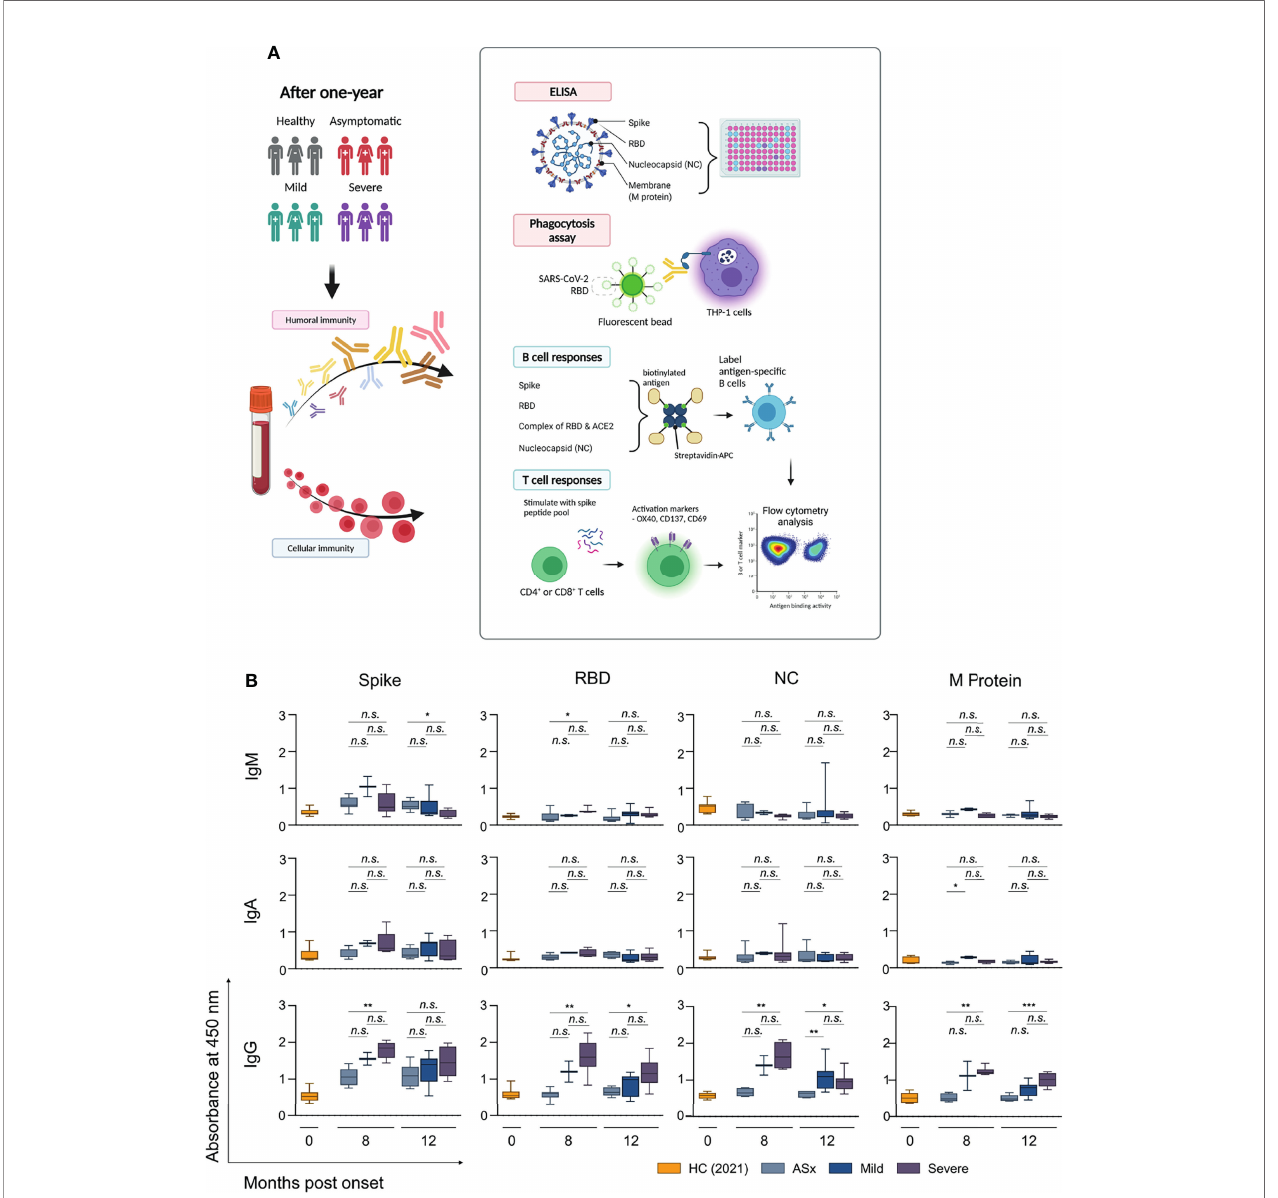
FIGURE 1 | Longitudinal analysis of anti-SARS-CoV-2 antibody in COVID-19 patients over time according to the severity of illness. (A) Schematic illustration (created with BioRender.com) of experimental design for analyzing humoral and cellular immune response to SARS-CoV-2 according to the disease severity, including Figures 1 – 4 . (B) Binding activities of each Ig isotype to SARS-CoV-2 proteins. Diluted plasma samples (1:100) in PBS were incubated with SARS-CoV-2 spike protein, receptor- binding domain (RBD), nucleocapsid (NC), and M protein. Corresponding isotyping Abs determined binding activities of IgM, IgA, and IgG to SARS-CoV-2 antigens. ASx, asymptomatic (8-month: n = 7, 12-month: n = 6), Mild (8-month: n = 2, 12-month: n = 9), Severe (8-month: n = 7, 12-month: n = 8). Statistical analyses were performed using the Kruskal – Wallis rank-sum test with Dunn ’ s post hoc test in GraphPad Prism ( n.s .: P > 0.05, * P < 0.05, ** P < 0.01, *** P <